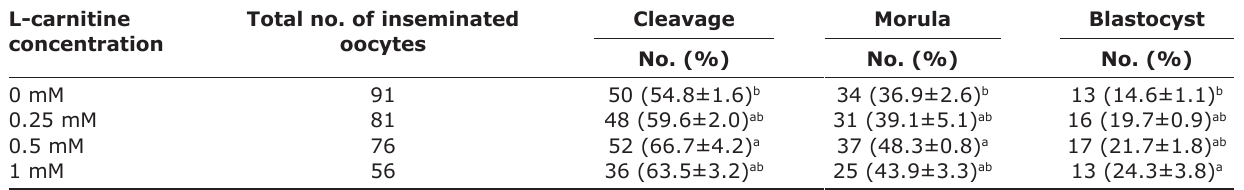
Table-2: Cryotolerance of buffalo embryos after culture supplementation with different concentrations of L-carnitine (Mean±SE). L-carnitine concentration